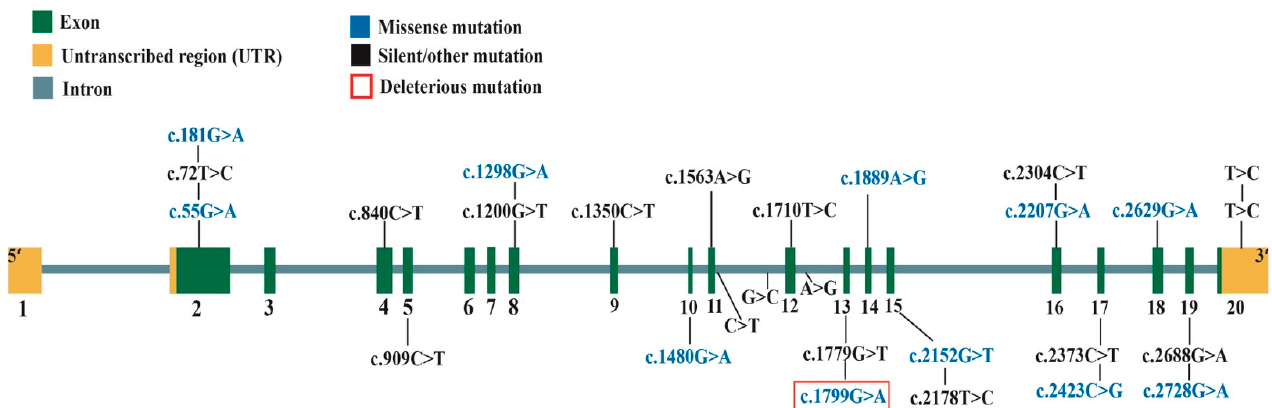
Figure 1. Identi fi ed variants in the GAA gene of the cat with Pompe disease. There were 21 homozygous coding, 2 heterozygous coding, 1 splice junction, 2 intronic, and 2 untranscribed region variants. The coding variants include 10 homozygous missense, 1 heterozygous missense mutation, and 12 silent mutations.